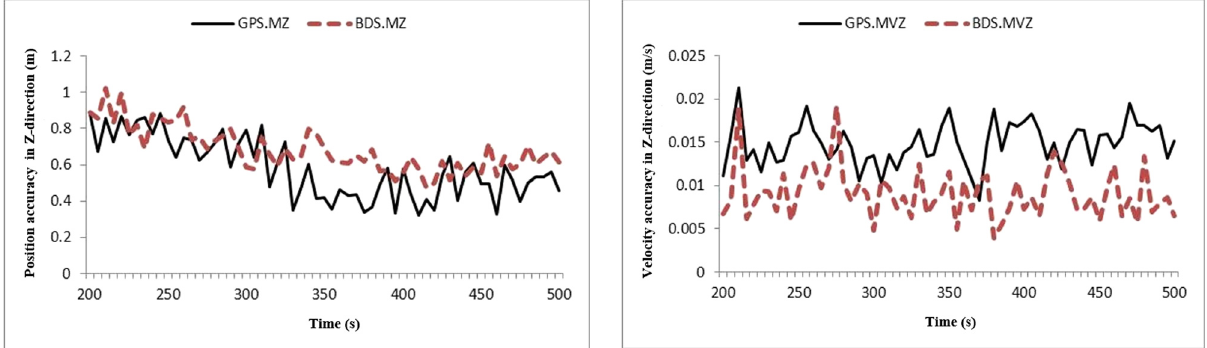
Figure 9: Velocity precision of on - board BDS and GPS in Z - direction.